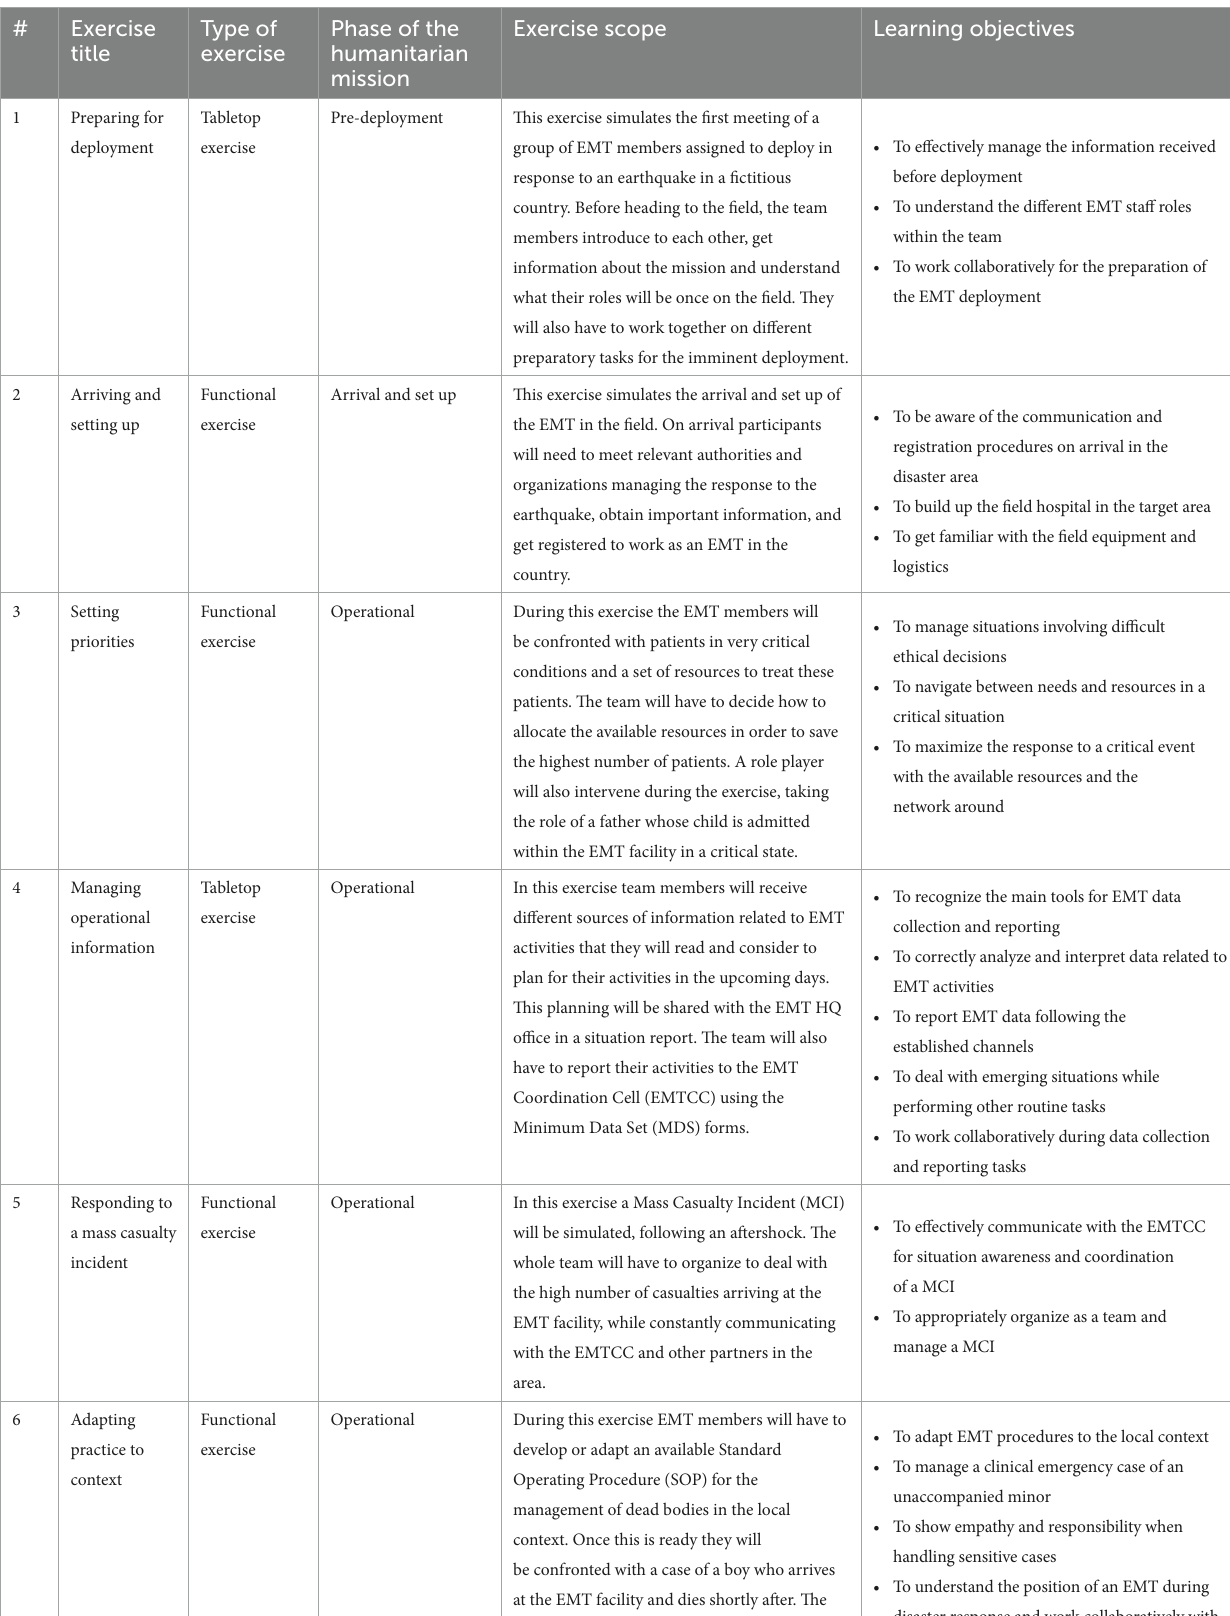
TABLE 1 Outline of TEAMS original training package consisting of 8